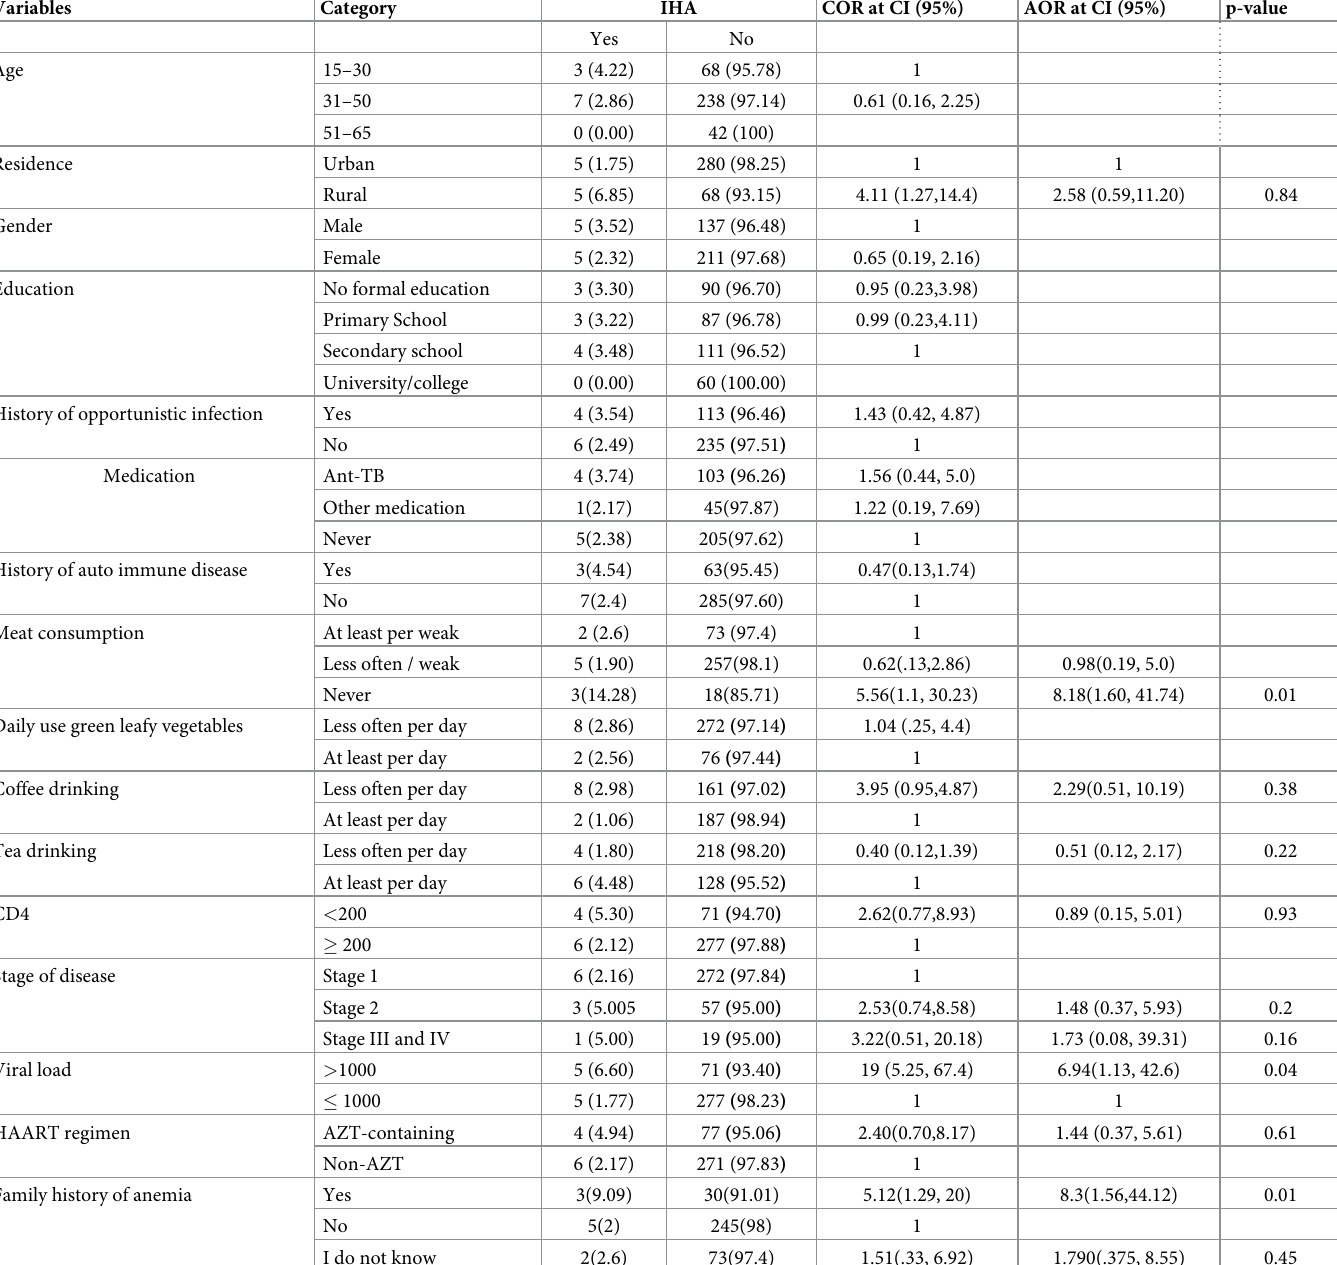
Table 4. Bivariable and multivariable firth penalized logistic regression model analysis of factors associated with IHA among HIV infected adults from March to April 2021 (N = 358).